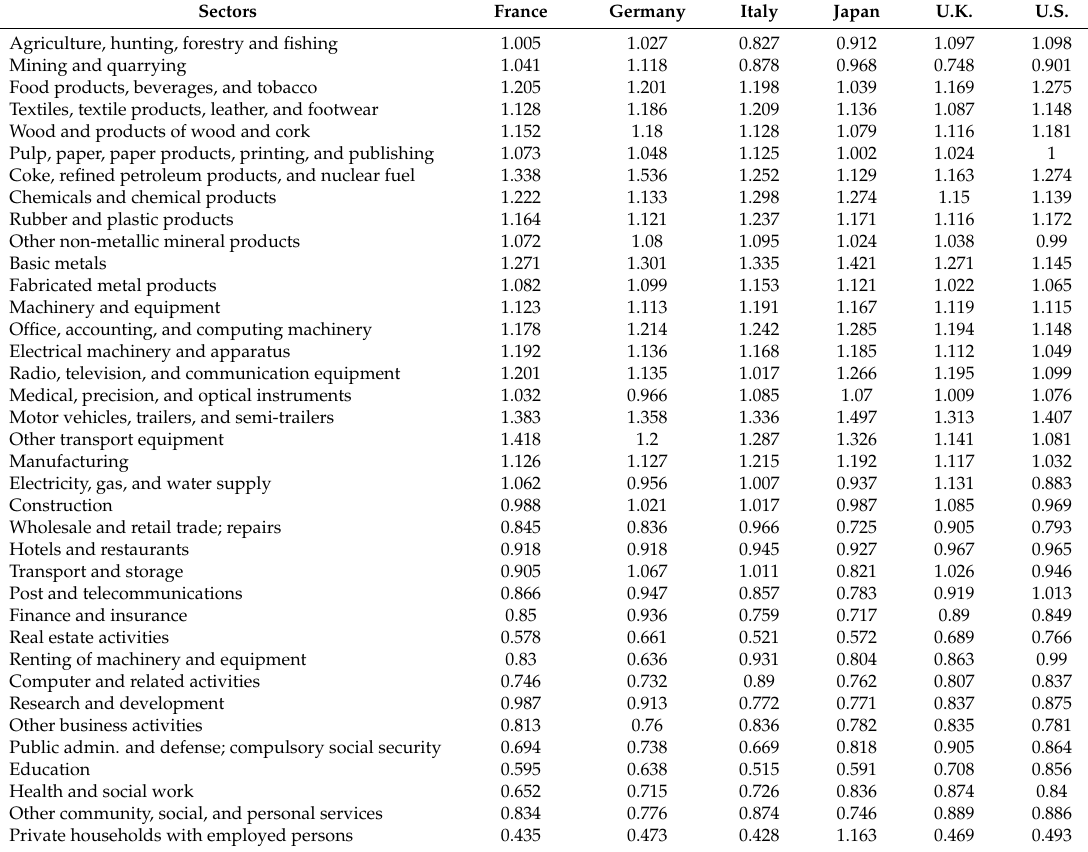
Table 1. Normalized Backward Linkage in Major OECD